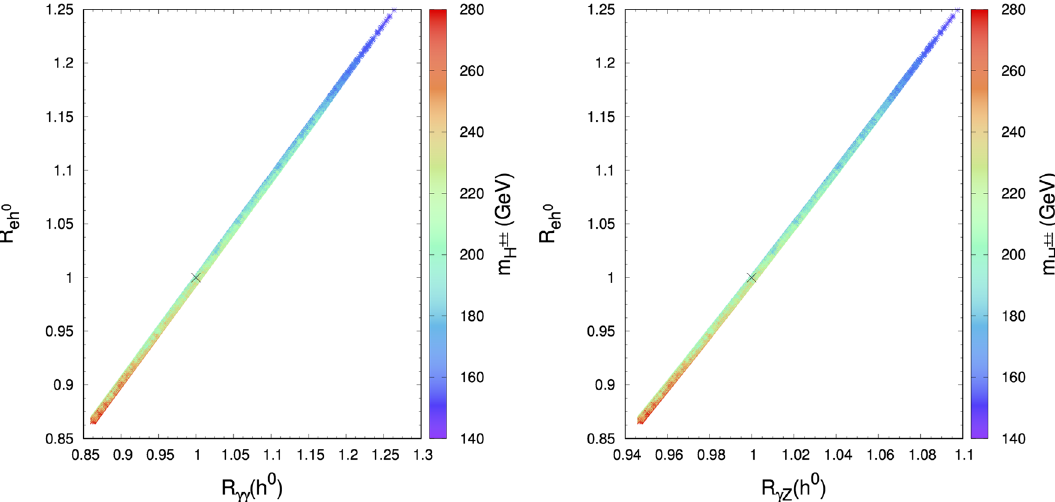
Fig. 7 R e − h 0 correlation with R γγ ( h 0 ) (left) and R γ Z ( h 0 ) (right) in the HTM. Color coding shows the variation of m H ±± . Inputs as in Fig.